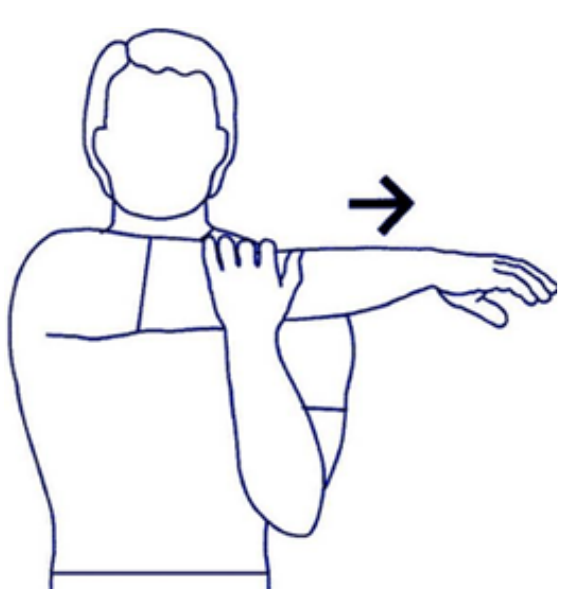
Figure 4. The “ cross body stretch ” , a useful technique to relax the posterior capsule of the glenohumeral joint.